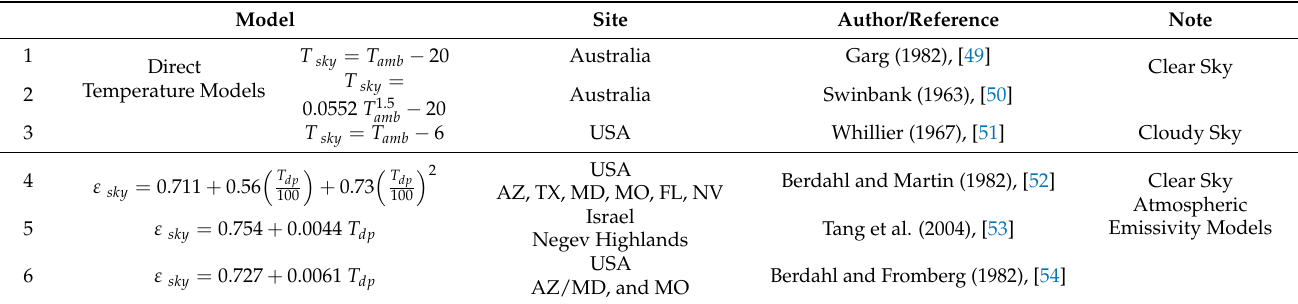
Table 2. Sky temperature and sky emissivity